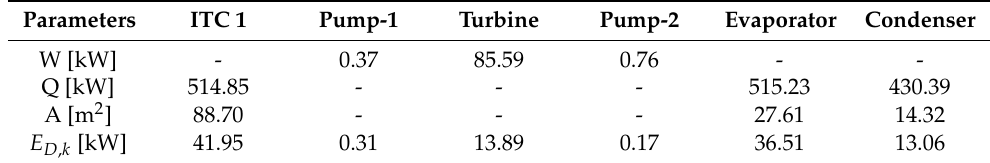
Table 12. Power, heat transfer area, and exergy destroyed of each component.